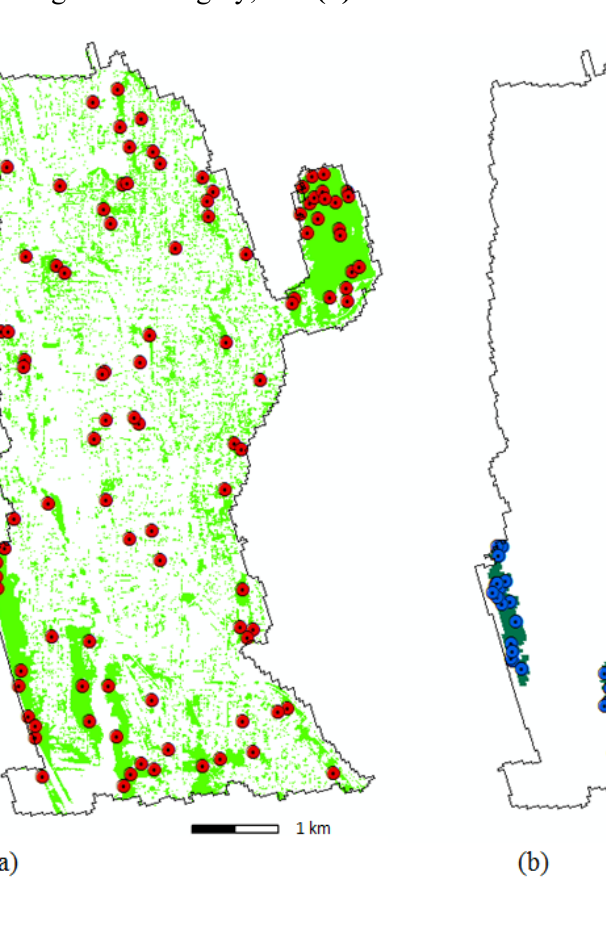
Figure 4. Sampling points based on: (a) OBIA-based LULC classification tree cover class using NAIP imagery, and (b) based on NLCD % canopy cover